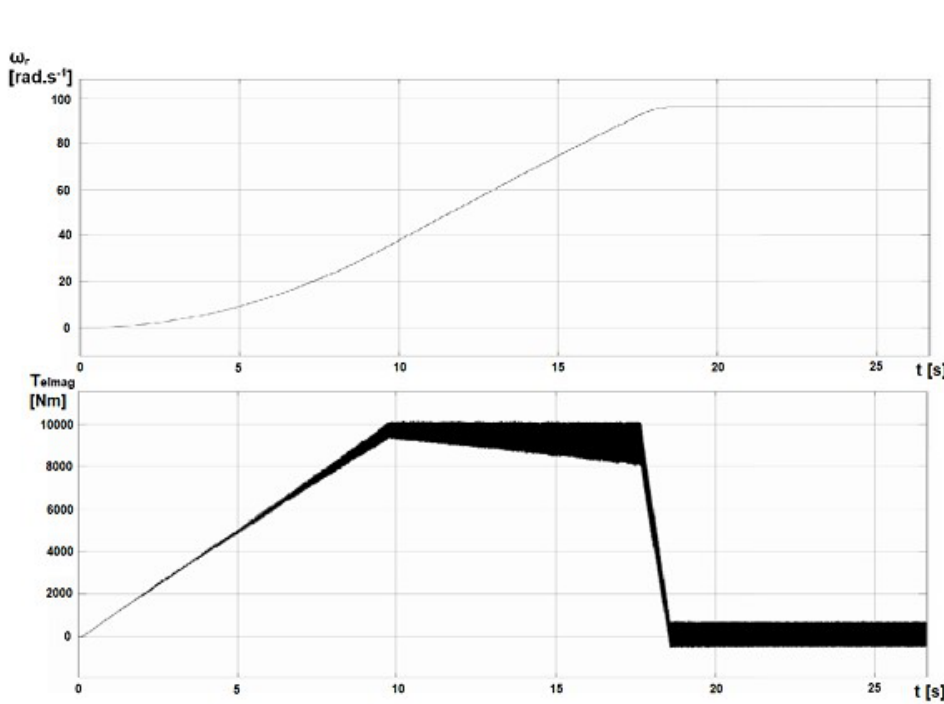
Figure 13. Rotor speed and rippled torque of asynchronous motor.